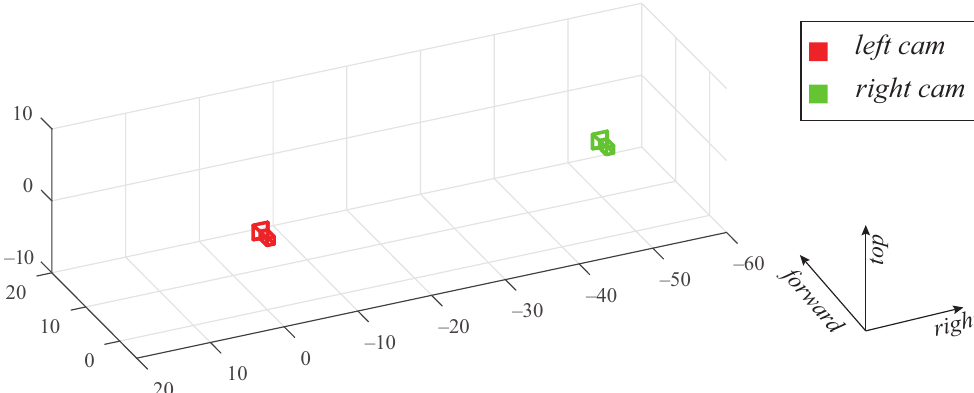
Figure 9. Extrinsic calibration result of stereo